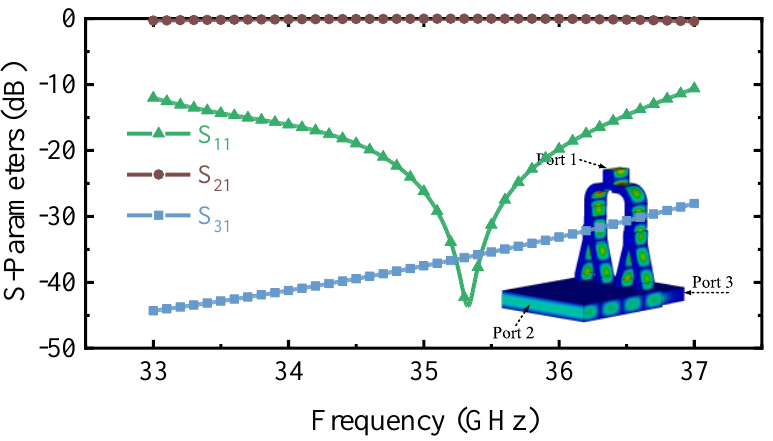
The multistaged matching is optimized to reduce the effects of port mismatches be- tween the power divider and mode converter. The two parts are connected by multistaged matching, and the simulation results of the mode converter with large α are shown in Figure 5. S 21 of the overmoded TE 01 mode is higher than − 0.45 dB, and S 11 is lower than − 10.5 dB between 33–37 GHz. Simulations predict an operation bandwidth higher than 4 GHz. The mode purity exceeds 99.8%, and the mode conversion efficiency is greater than 95%. The S 11 reaches up to − 43.6 dB at 35.3 GHz, and the S 11 is up to − 0.011 dB. The results indicate that the overmoded mode converter has a good performance. Moreover, the simulation results are also similar to the small α mode converter and demonstrate the feasibility of the method to obtain the mode converter with a different α by using similar topologies.